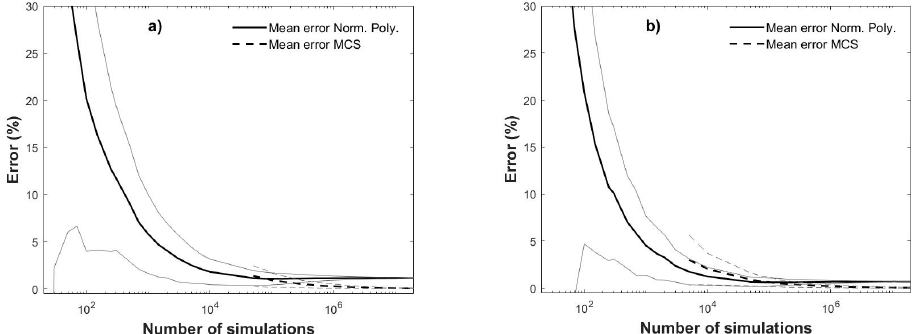
Figure 4. Deviations from the exact reliability index as percentage error for RCB; ( a ) r V / D = 0.4 and ( b ) r V / D = 2.0.